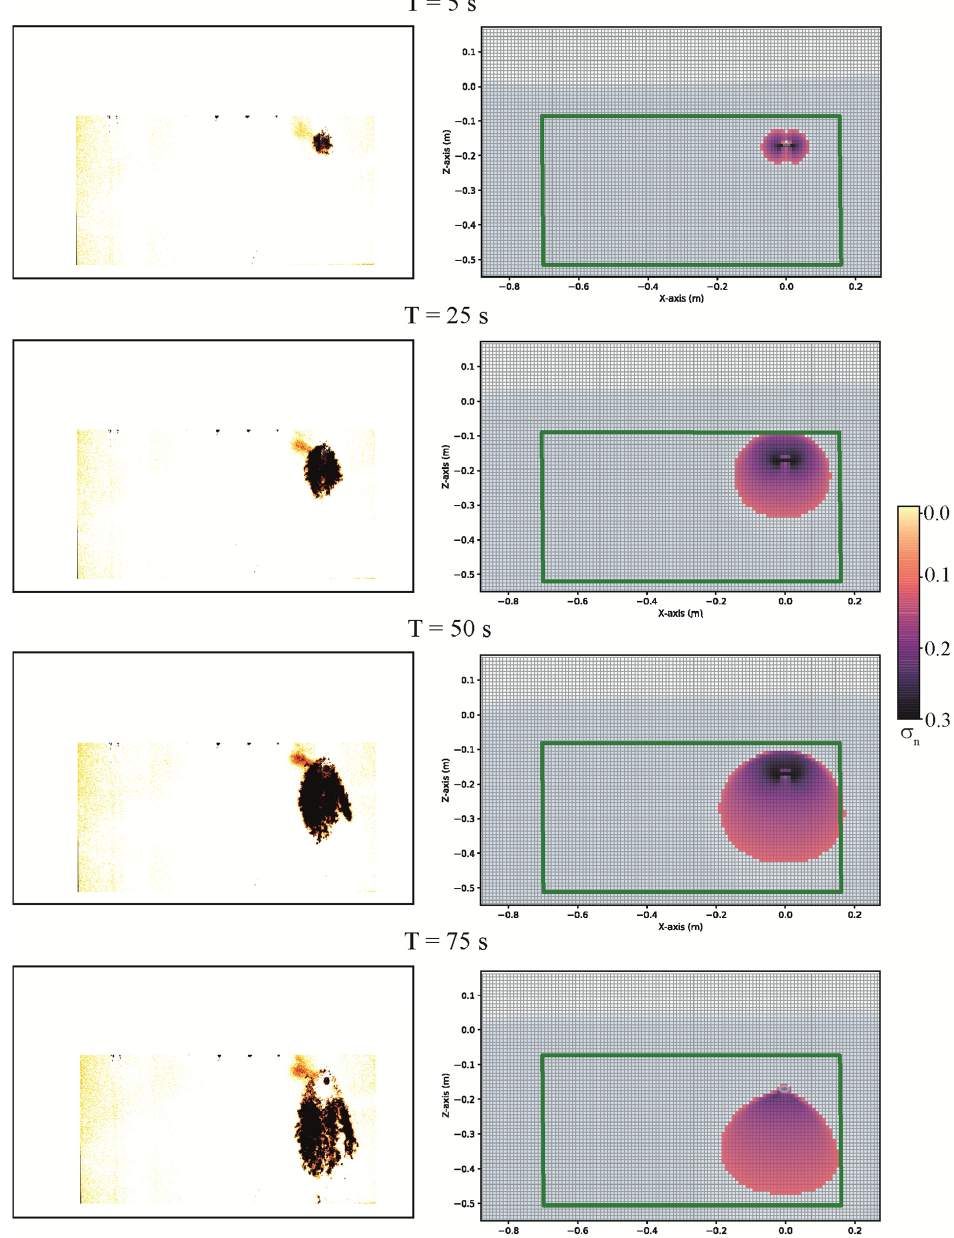
Figure 6. Comparison between the experimental results on the DNAPL migration in a sandbox and three-dimensional numerical results on the saturation contours ( σ n = S n φ ) of the DNAPL in a sandbox using a grid dimension of 0.060 m × 0.060 × 0.360 m at different times: 5 s, 25 s, 50 s, 75 s, respectively. The left-hand side of each panel time shows the experimental result in the sandbox, while the saturation contours of the DNAPL migration in the (cid:4666)𝑧 − 𝑥(cid:4667) plane are placed on the right-hand side of each panel.